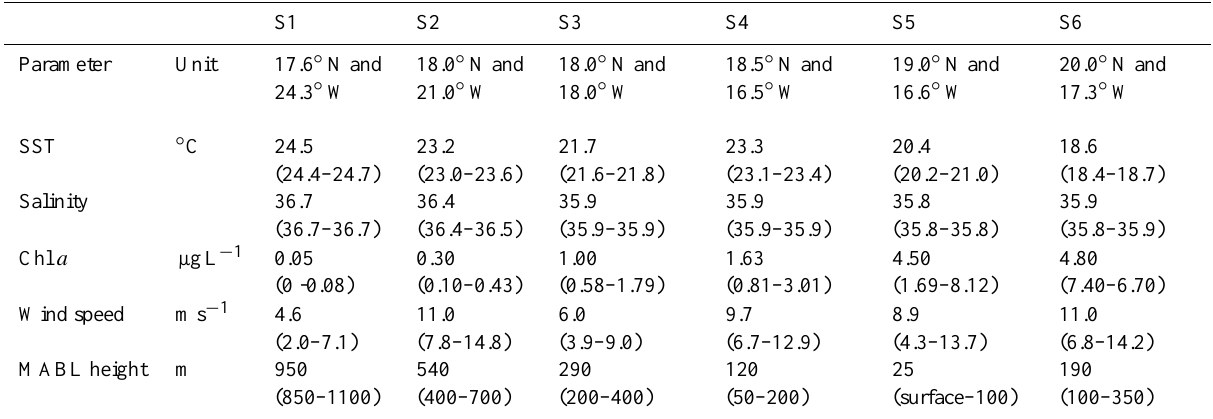
Table 1. Means and ranges (minimum – maximum) of ambient parameters (SST, salinity, Chl a , wind speed, MABL height) during DRIVE for open ocean stations S1–S2 and coastal stations